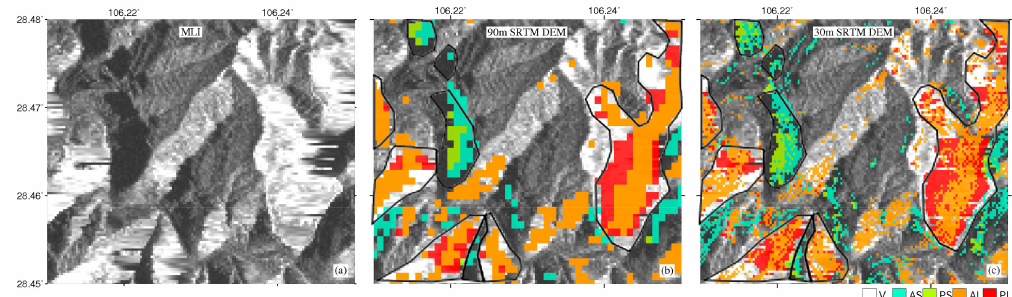
Figure 9. Intensity image of the ALOS descending data ( a ); the layover/shadow simulated based on 90-m SRTM DEM ( b ) and 30-m SRTM DEM data ( c ). V: “real” layover/shadow by visual interpretation; AS: active shadow; PS: passive shadow; AL: active layover; PL: passive